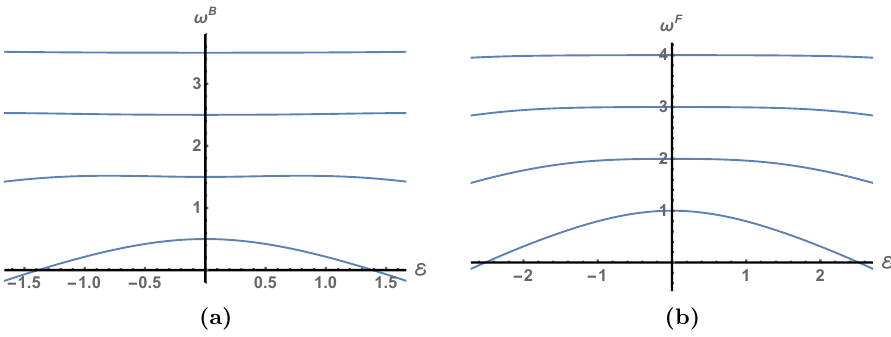
Figure 19. The (cid:12)rst four energy levels for (a) the m = 0 sector of the free boson, and (b) the m = 1 = 2 sector of the free fermion, as a function of the dipolar potential